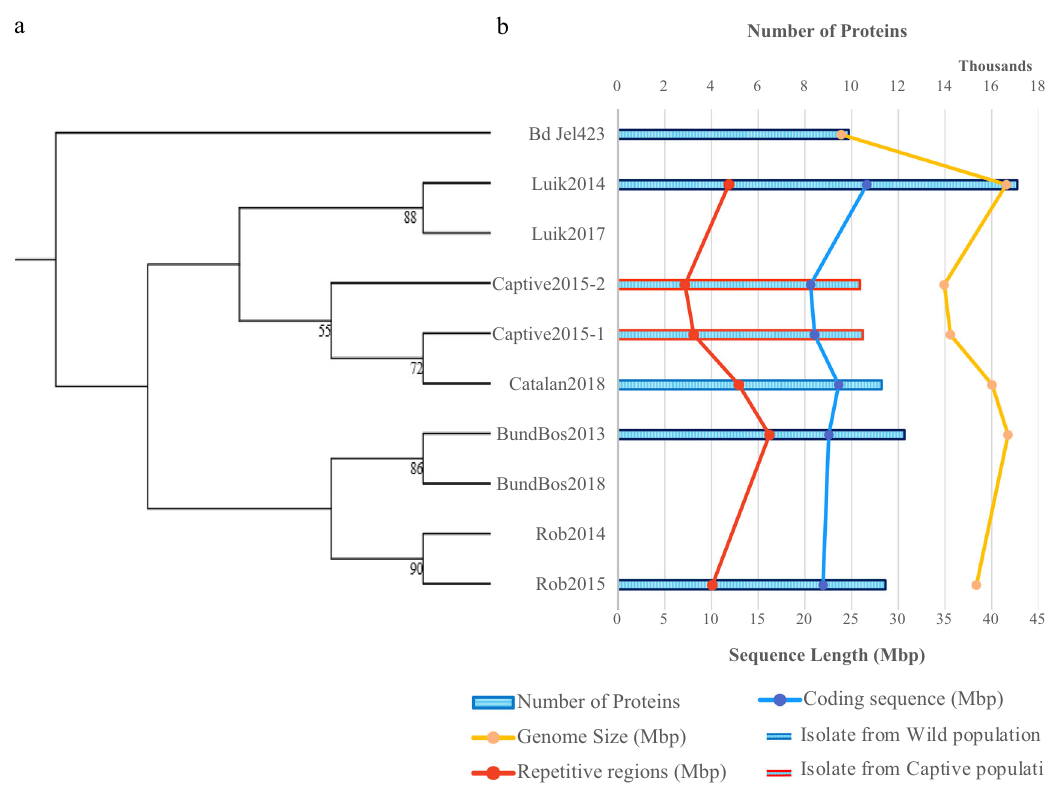
Fig. 1 Summary of genomic features, location and phylogeny of Batrachochytrium salamandrivorans isolates. a RAxML inferred phylogeny constructed using 36,495 SNPs in linkage equilibrium, including Bd Jel423 isolate (PRJNA13653, GCA_000149865.1, Farrer et al. 14 ) as an outgroup; values represent bootstrap support; b isolate assembly summary where bars represent gene count and lines represent total repetitive sequence length (red), total coding sequence length (blue) and genome size (yellow). BundBos2013 represents the ground zero isolate from the Netherlands in 2013; BundBos2018 was isolated from the same outbreak population in 2018; Luik2014 is from an outbreak near Liege, Belgium in 2014; Luik2017 was isolated from the same outbreak in 2017. Rob2014 is from an outbreak in 2015 near Robertville, Belgium, <40 km from Liege, and Rob2015 was isolated from the same outbreak in 2015. Catalan 2018 was isolated from an outbreak in the Montnegre i el Corredor Natural Park, Catalonia, Spain. Captive population locations cannot be disclosed in order to maintain anonymity, both were isolated in